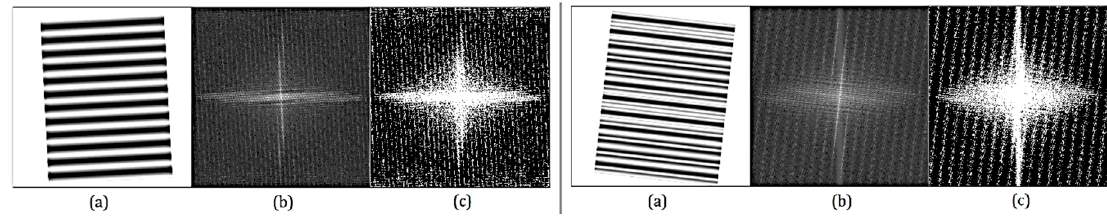
Figure 1. (a) Stripes image sample I ; (b) Fast Fourier Transform (FFT)(I); (c) OTSU(FFT(I)). Figure 1. ( a ) Stripes image sample I ; ( b ) Fast Fourier Transform (FFT)(I); ( c )